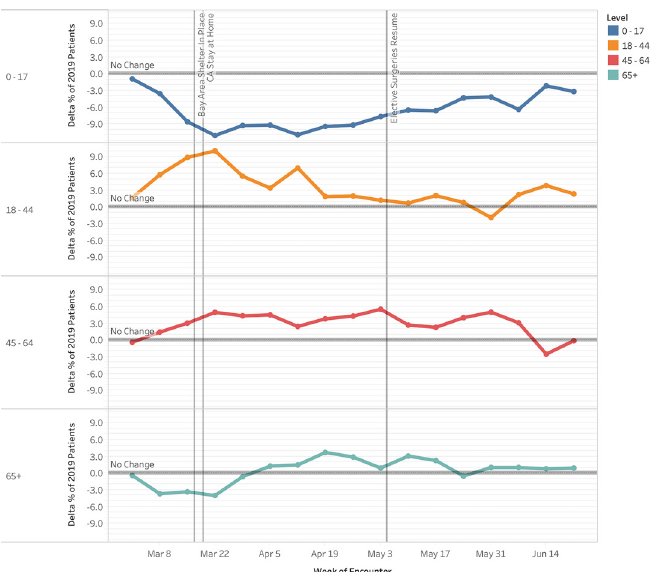
Figure 2. Change in proportion of patients by age (years)